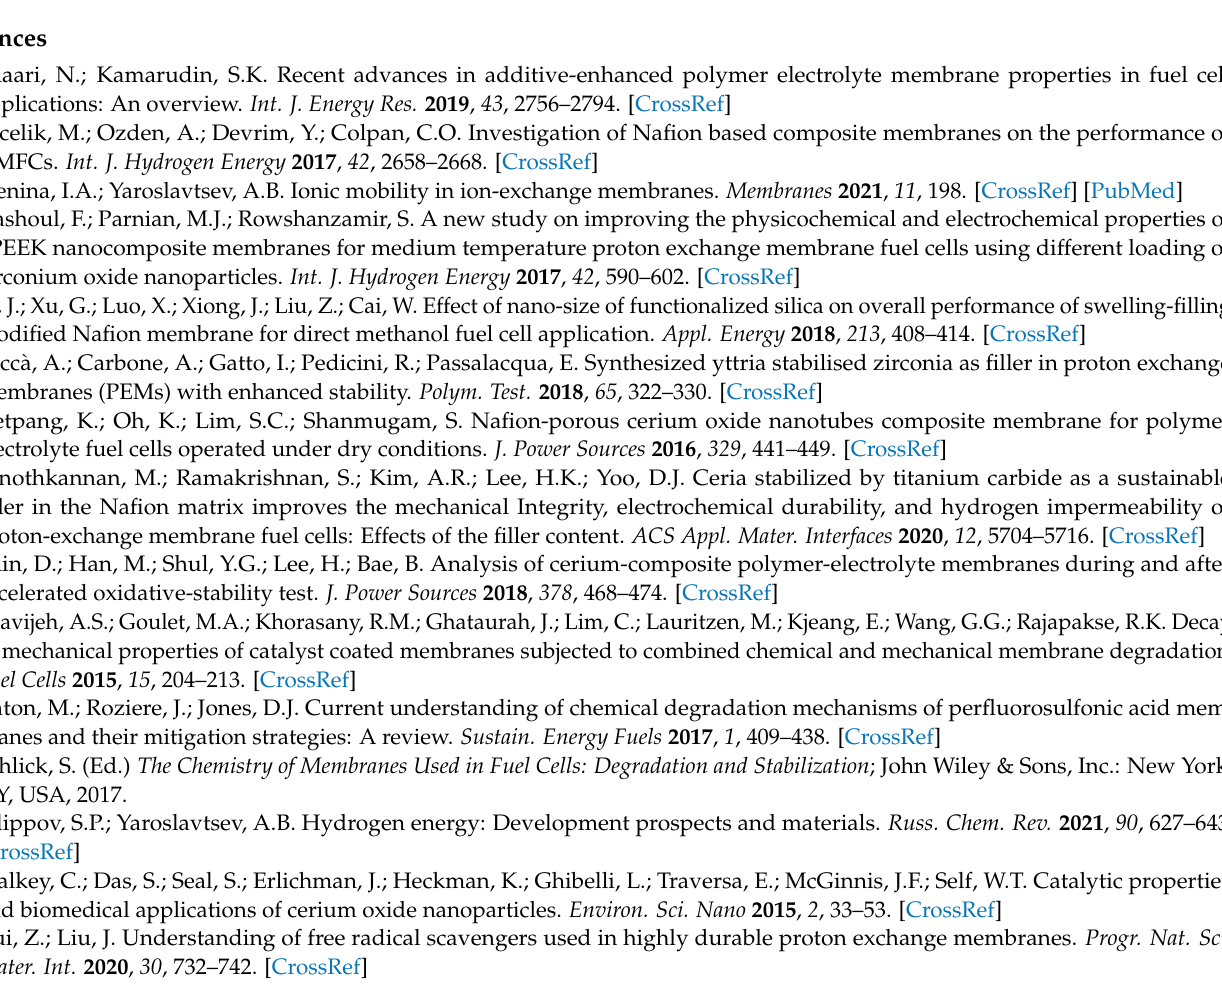
Figure S2: Nyquist plots of the NC4(S) composite membrane recorded at different temperatures in contact with water (a) and 30% RH (b), Figure S3: Stress–strain responses of the pristine Nafion-117 (1) and the NC3 (2), NC4_1P (3), NC4(S) (4), and NC4(NS) (5) hybrid